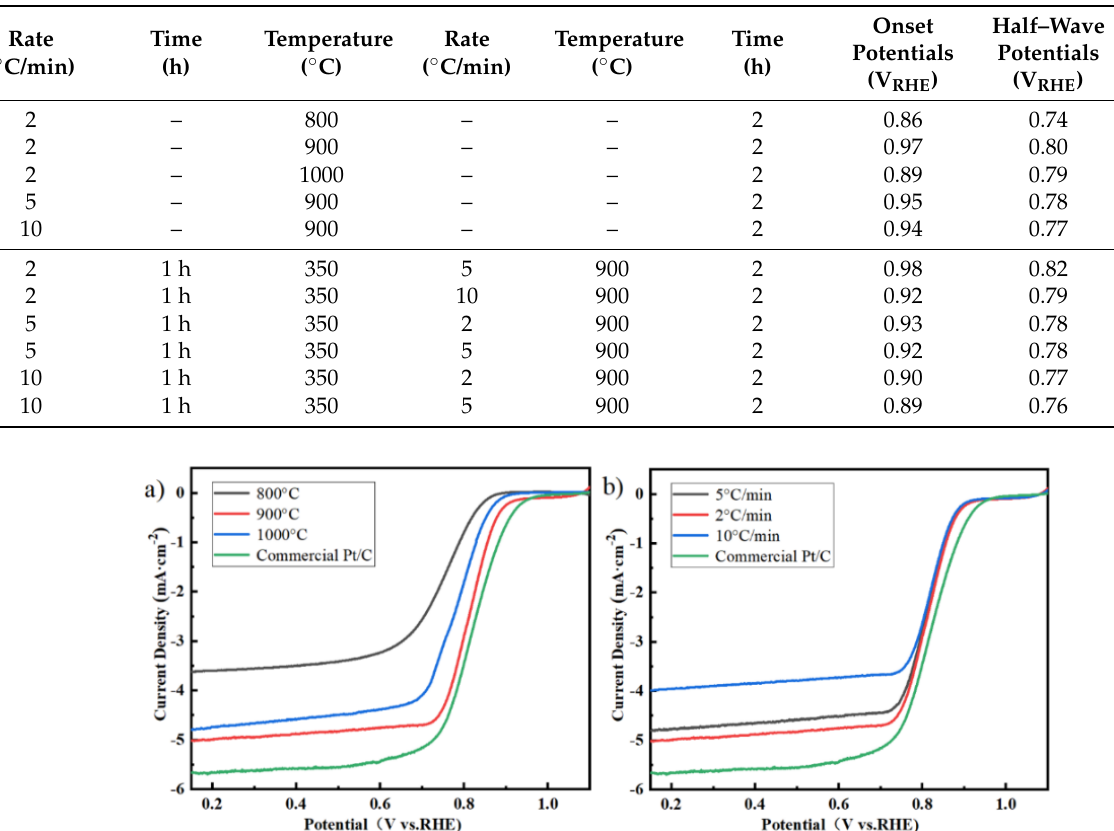
Table 1. The pyrolysis conditions and performance of the Co–ZIF–8 precursor.